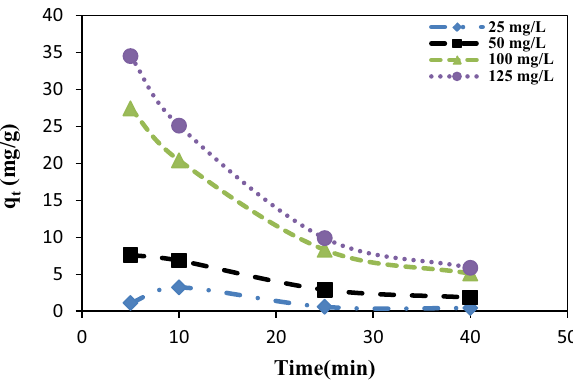
Fig. 9 Fitting of the nonlinear Ho model with the adsorption kinetic